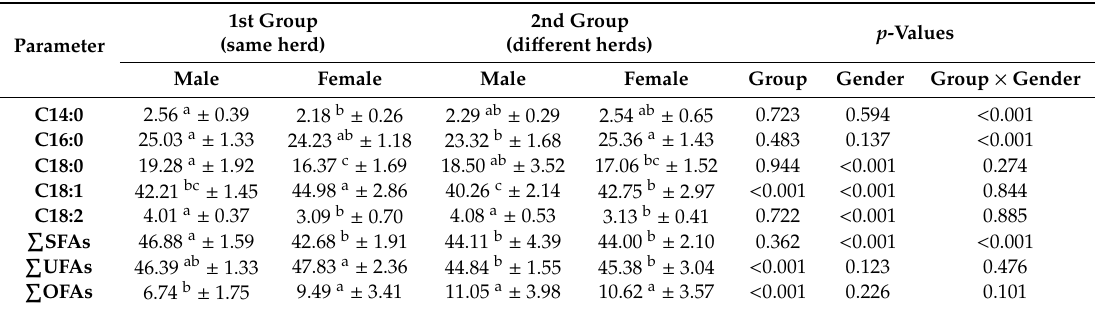
Table 6. Fatty acid composition (g / 100g fat) of fresh M. longissimus lumborum from investigated groups of Simmental